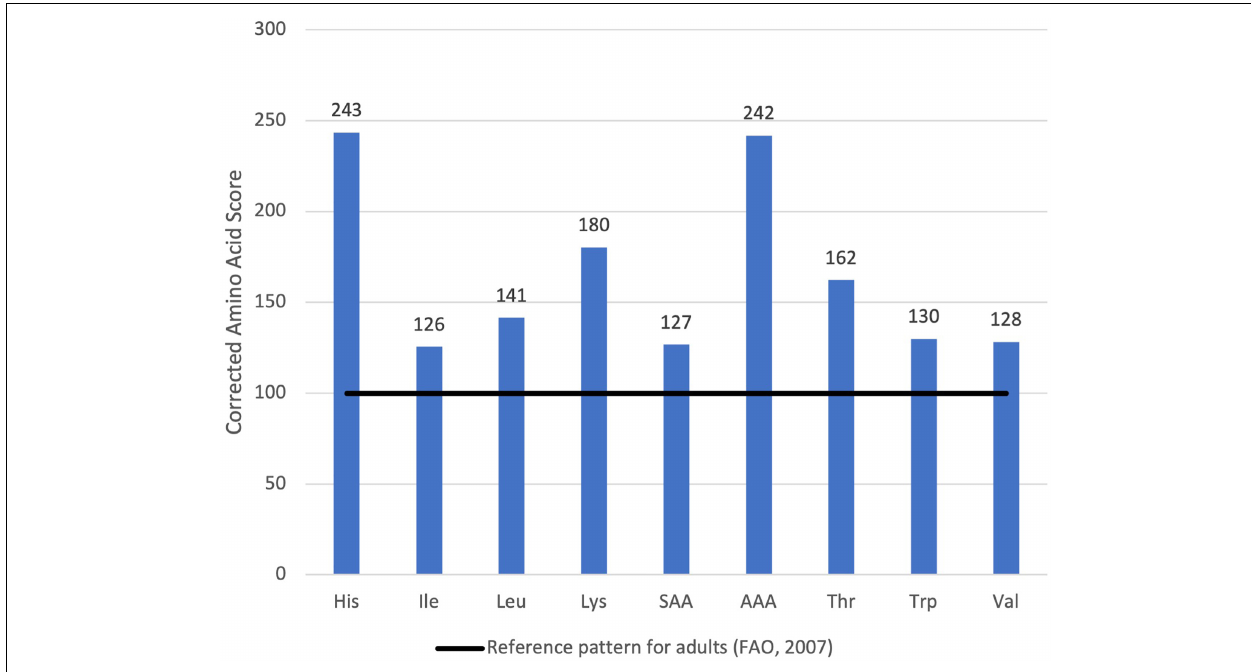
FIGURE 5 | Corrected Amino Acid Score of optimized formula for yogurt analogue.